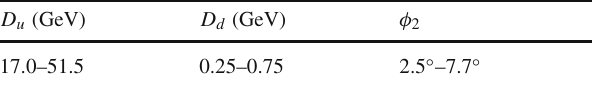
Table 4 Parameter ranges for the mass matrices given in Eq. (13) that reproduce the mixing parameters given in Table 1 D u (GeV) D d (GeV) φ